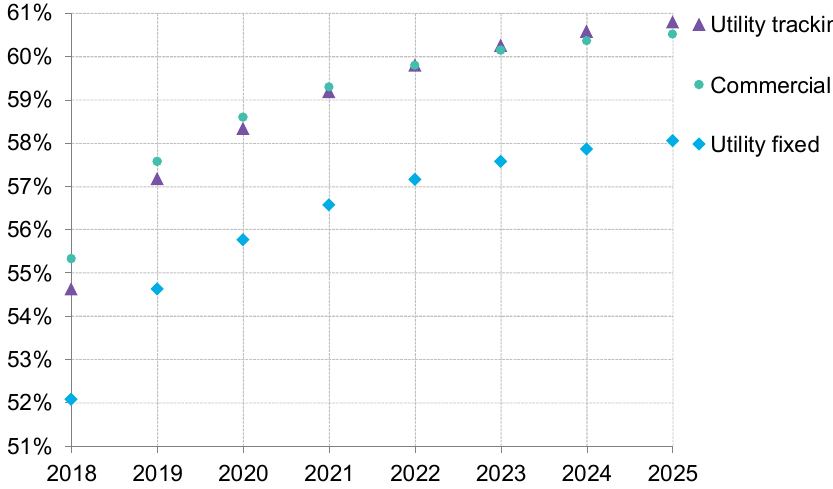
Figure 10. Estimated percentage of area-proportional and fixed non-module costs in PV capex.